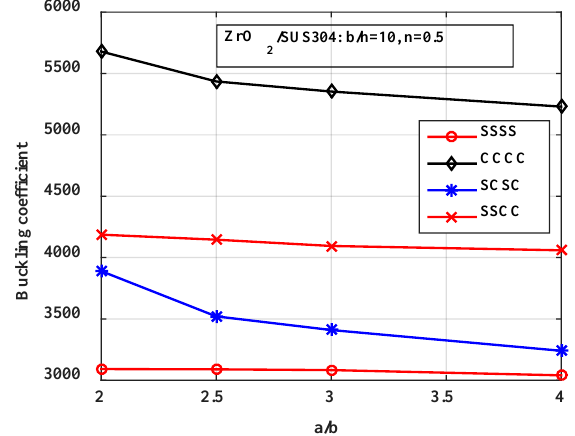
Figure 11. Variation of the buckling coefficient by the boundary condition and the length of the plate.